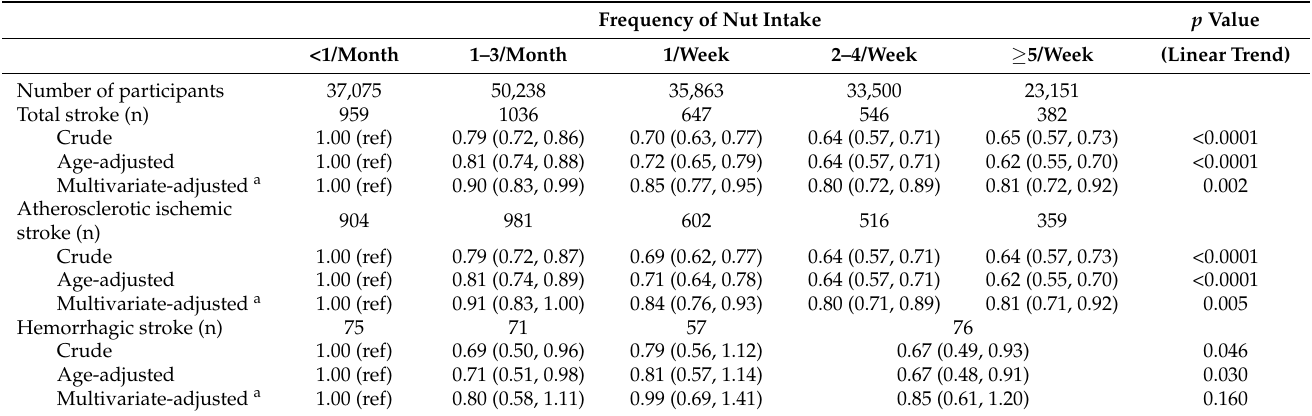
Table 2. Association of nut intake and risk of